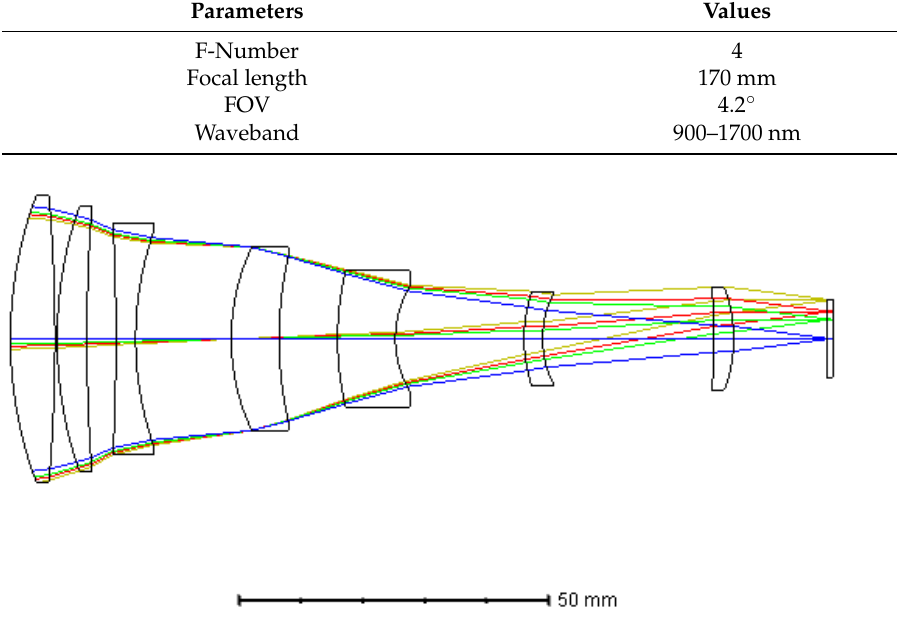
Figure 5. Optical layout of the fore-optics.